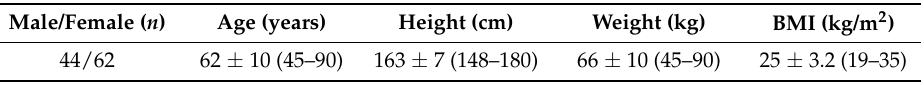
Table 1. General information on 106 subjects (AVE ± SD and ranges).